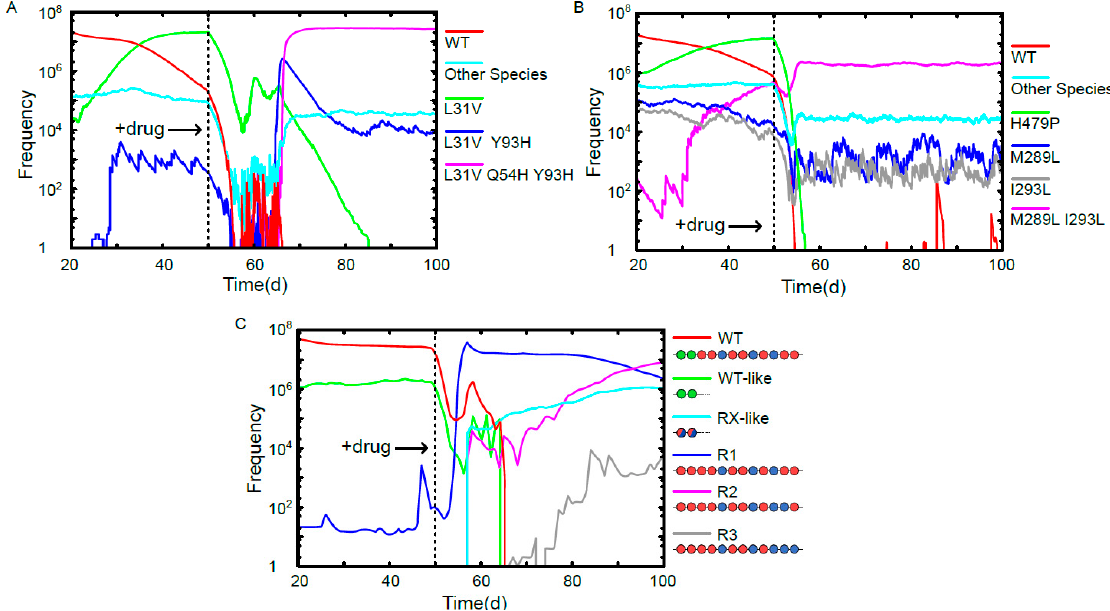
Figure 3. Evolutionary trajectories of vRNAs in the viral quasispecies in a drug escape scenario. ( A ) Time evolution of vRNAs in the viral quasispecies under the conditions of a chronic infection and exposure to Daclatasvir at day 50. WT and mutants L31V, L31V Y93H, L31V Q54H Y93H are shown on an individual basis, and all other species are grouped together. L31V is on the pathway to the therapy-resistant triple mutant L31V Q54H Y93H, which is the dominant species from day 66; ( B ) time evolution of vRNAs in the viral quasispecies under a chronic infection treated with Sofosbuvir at day 50. WT, H479P, M289L, I293L and M289L I293L are shown on an individual basis, and all other species are grouped together. At day 50, the single mutant H479P is dominant, but has poor drug resistance, and is displaced as the dominant vRNA by the more resistant double mutant M289L I293L after day 55; ( C ) the time evolution of vRNAs in the viral quasispecies under chronic infection conditions and exposure to a PS-binding assembly-inhibitor at day 50. WT and the three emergent therapy-resistant vRNAs R1, R2 & R3 are shown individually, while WT-like vRNAs (characterised by having two high-affinity PSs at the 5’ end as in the WT) and R1/2/3-like vRNAs (containing only intermediate and low affinity PSs) are shown as groups. The dominant species following drug exposure is R1, which is then displaced by R2 after day 87. The sequence R3 is present at low frequencies at day 100, but becomes the dominant species from day 190.